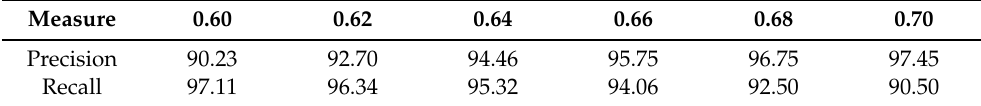
Table 2. The average precision and recall of all vehicles under different thresholds.